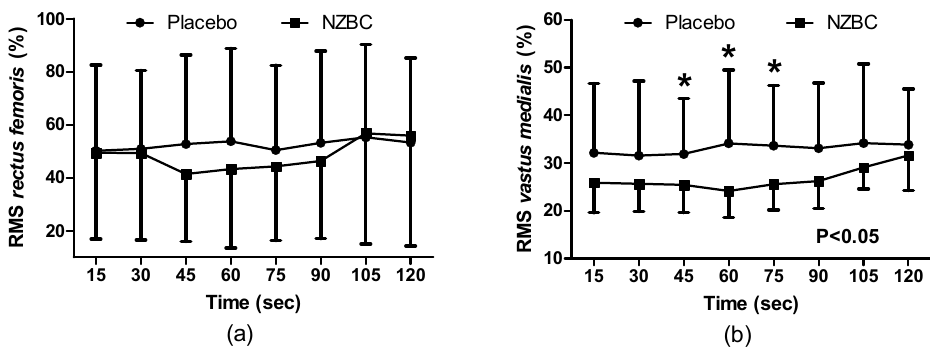
Figure 2. Normalised root mean square (RMS) of the rectus femoris muscle ( a ) and the vastus medialis muscle ( b ) during a 120 s 30%iMVC for placebo and after 7-days intake of NZBC (New Zealand blackcurrant) extract capsules. Data are mean ± SD. * difference between placebo and NZBC extract.